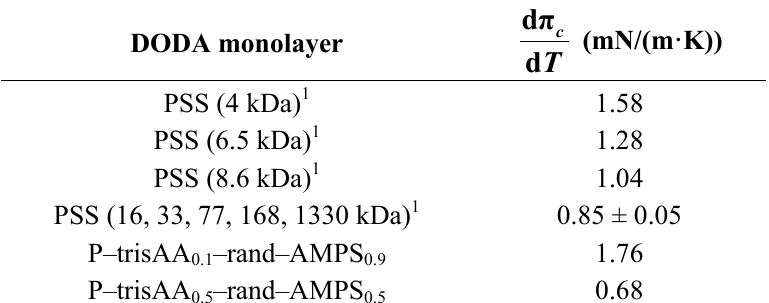
concentration of all PEs is 0.01 mmol/L in monomer